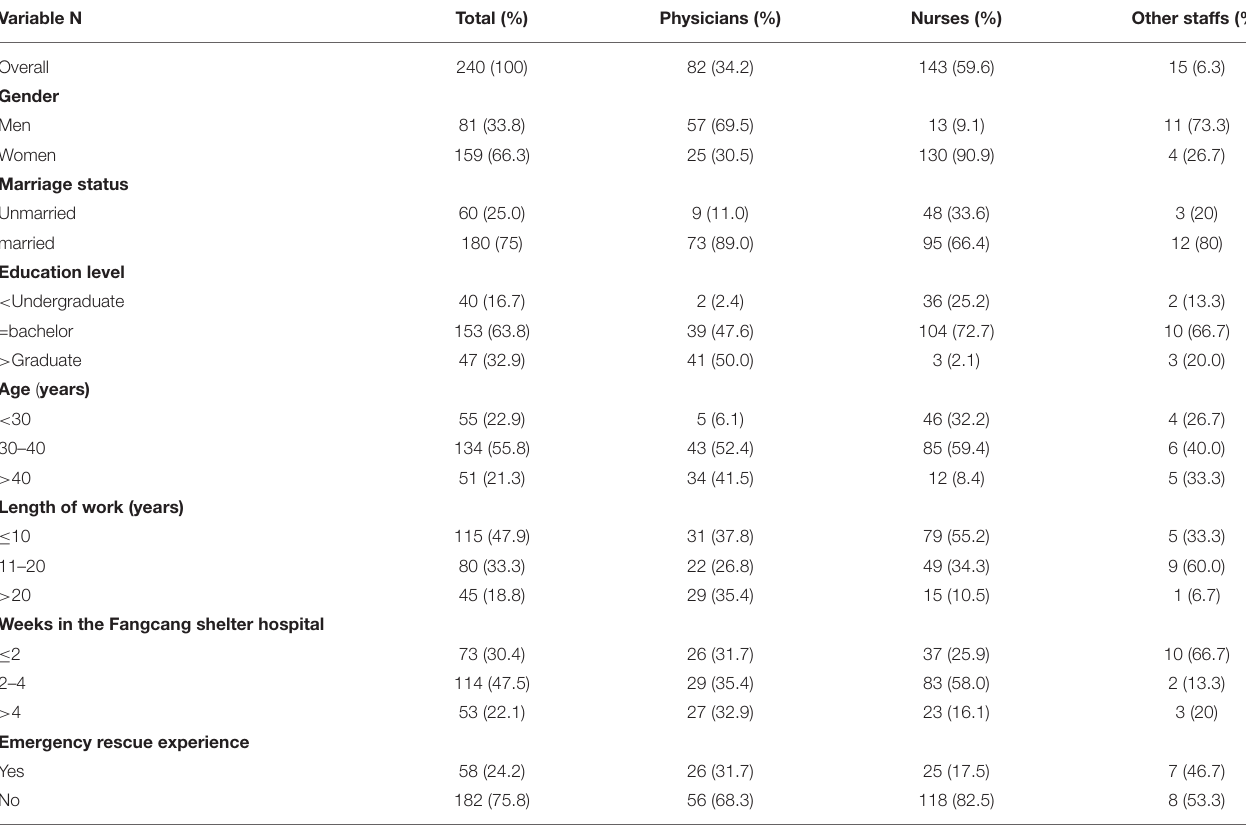
TABLE 1 | Demographic characteristics of participants.